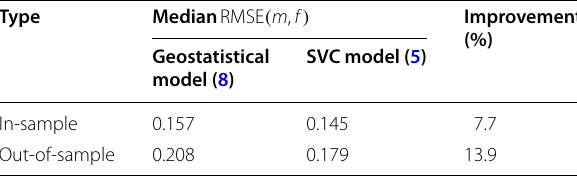
Table 5 Summary of tenfold